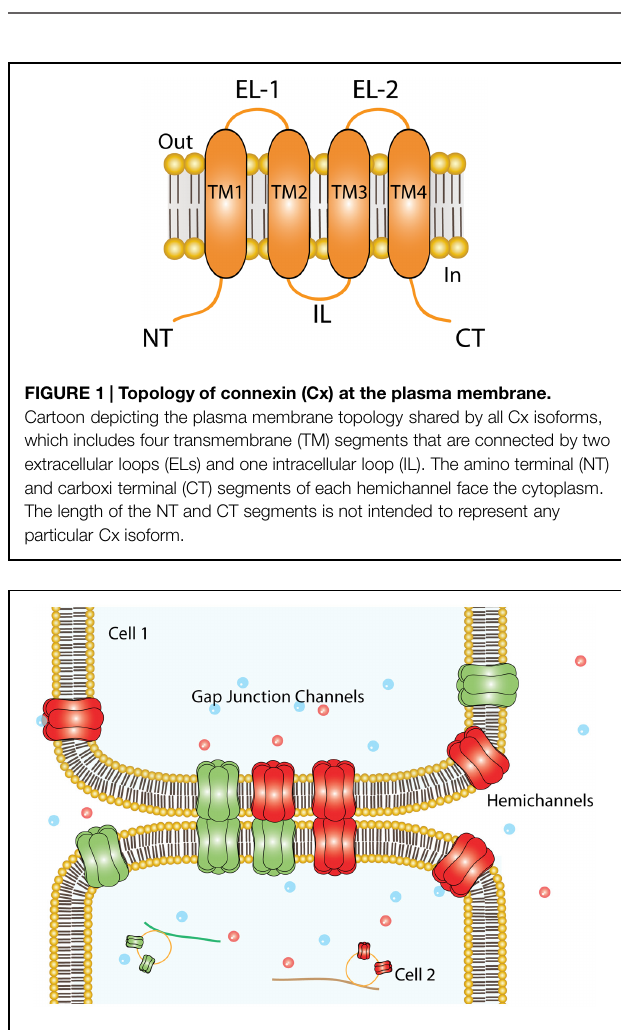
FIGURE 2 | Plasma membrane arrangements of Cxs. Six Cxs oligomerize to form a HC that traveled to the non-appositional plasma membrane to form free HCs, which provide an auto/paracrine communication pathway between the cell and the extracellular milieu. Alternatively, can dock others HCs provided by an adjacent cell (appositional plasma membrane) to form intercellular aqueous pore named gap junction